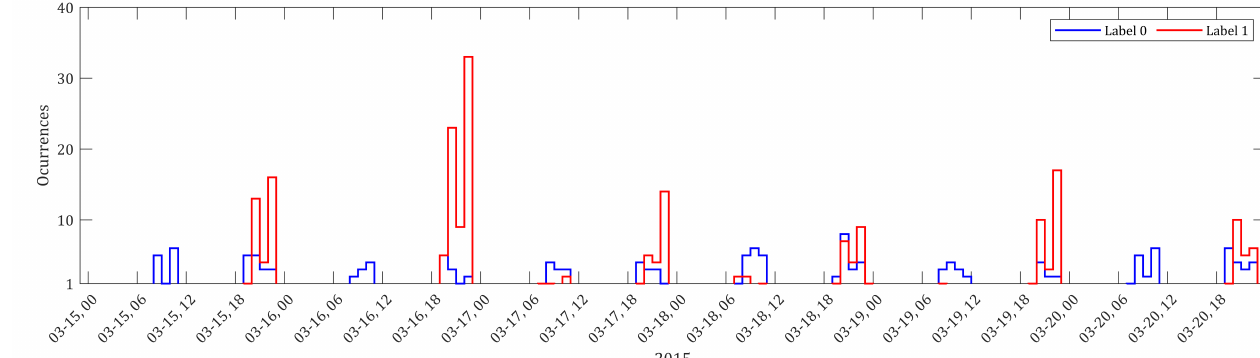
Figure 8. Local time distribution of labelled occultations between March 15th (DOY 74) and March 20th (DOY 79) in 2015. Label 1 observations correspond to the majority of the observations composing the data set in this period, likely related to the solar cycle